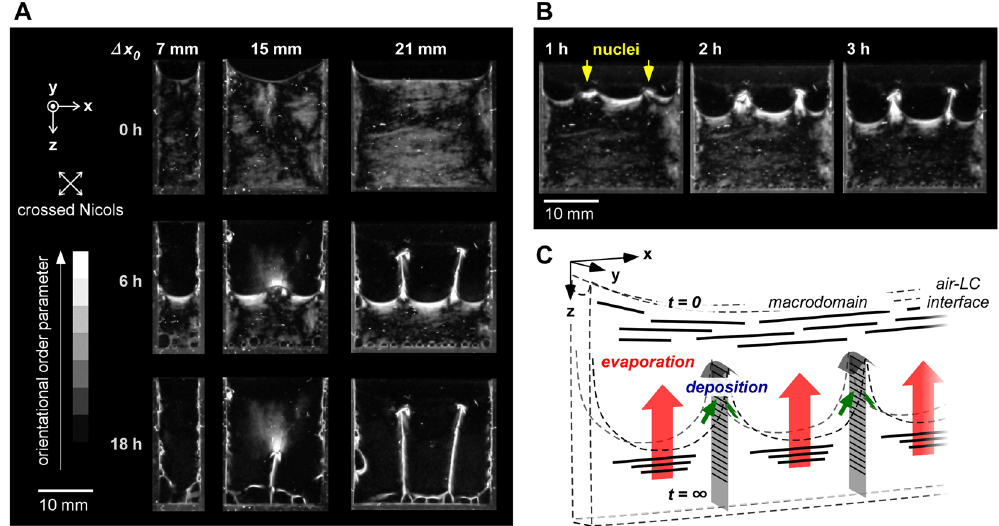
Figure 4. Multiple nuclei deposition to form vertical membrane walls and macro-space partitioning. ( A ) Time courses of vertical membrane formation during drying from top-side-open cells with X -width, ∆ x 0 = 7, 15, and 21 mm. The images were acquired under cross-polarized light. ( B ) Initial time course of the nucleation from the cell with X -width, ∆ x 0 = 21 mm. The Y -thickness is ∆ y 0 = 1 mm. Initial concentration of sacran : 0.5 wt%. Drying atmosphere: 60 °C under air pressure. C . Mechanism of multiple vertical membrane formation through non- equilibrium state between deposition and hydration during drying in limited